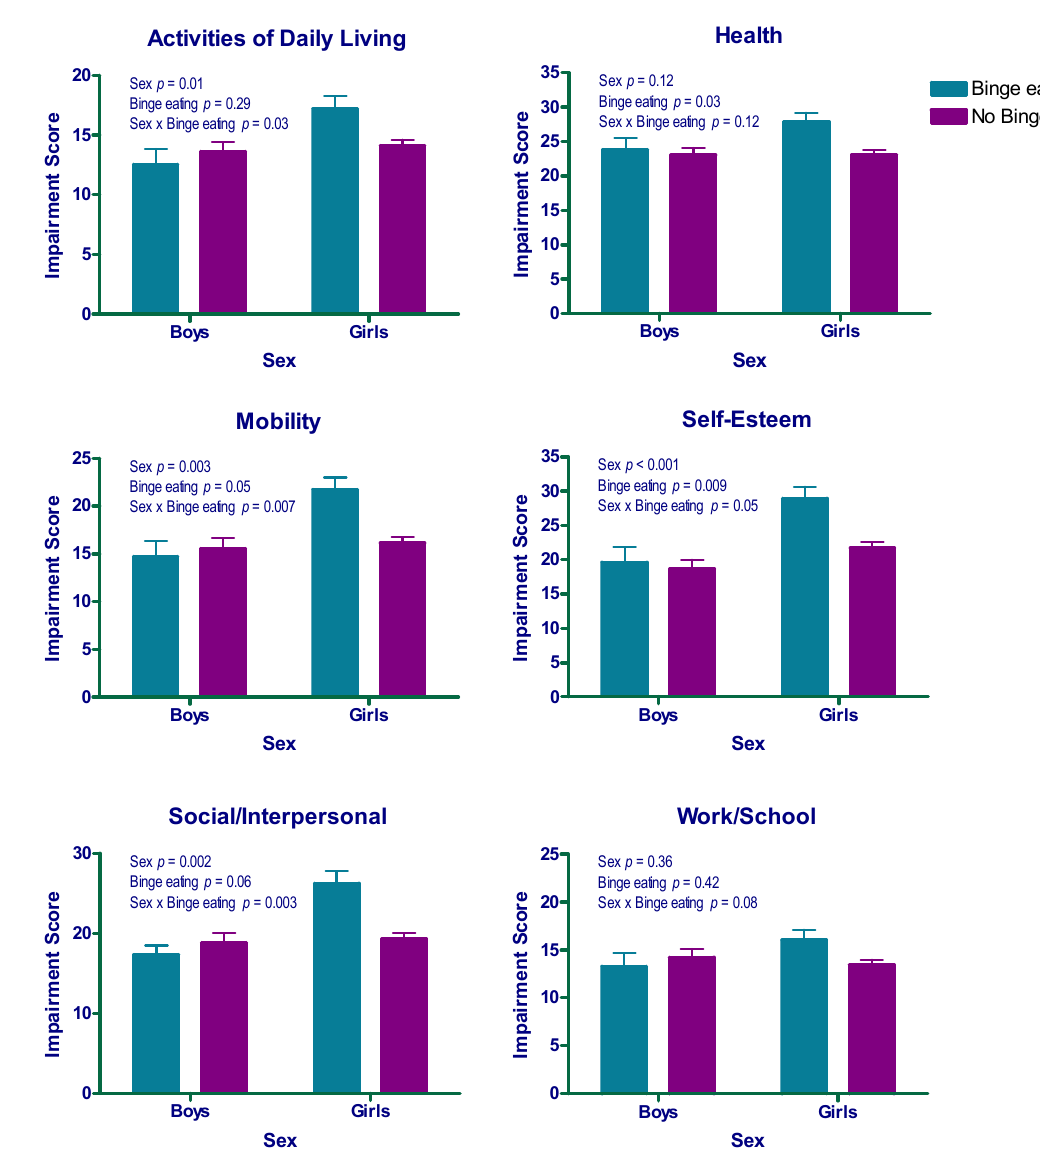
Figure 1. Adjusted means and standard errors for girls and boys with and without binge eating on the quality of life (QOL) domains of activities of daily living, health, mobility, self-esteem, social/interpersonal, and work/school, adjusted for age (years), race (Caucasian versus African American), percent body adiposity (%), fat-free mass (kg), and height